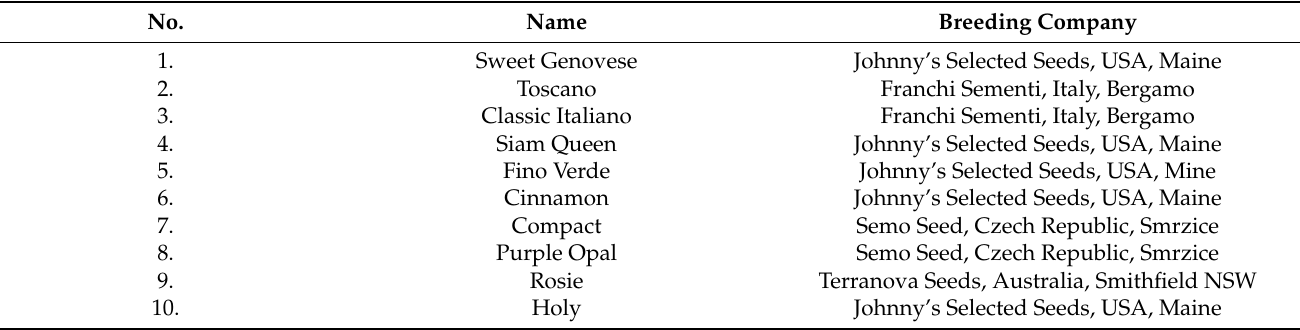
Table 7. Representation of